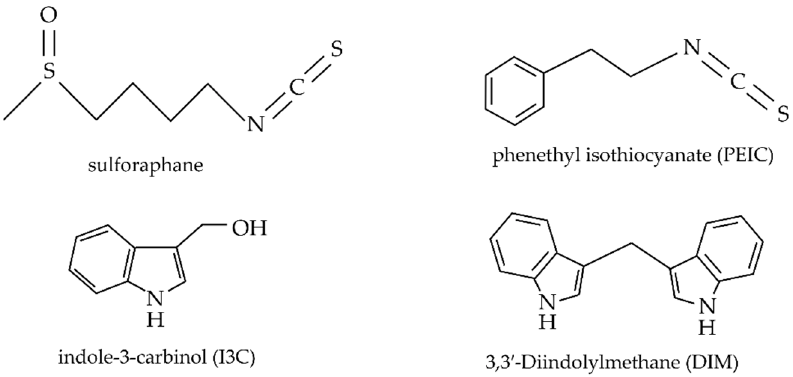
Figure 3. Chemical structures of the breakdown products sulforaphane, PEITC, I3C and DIM [75].